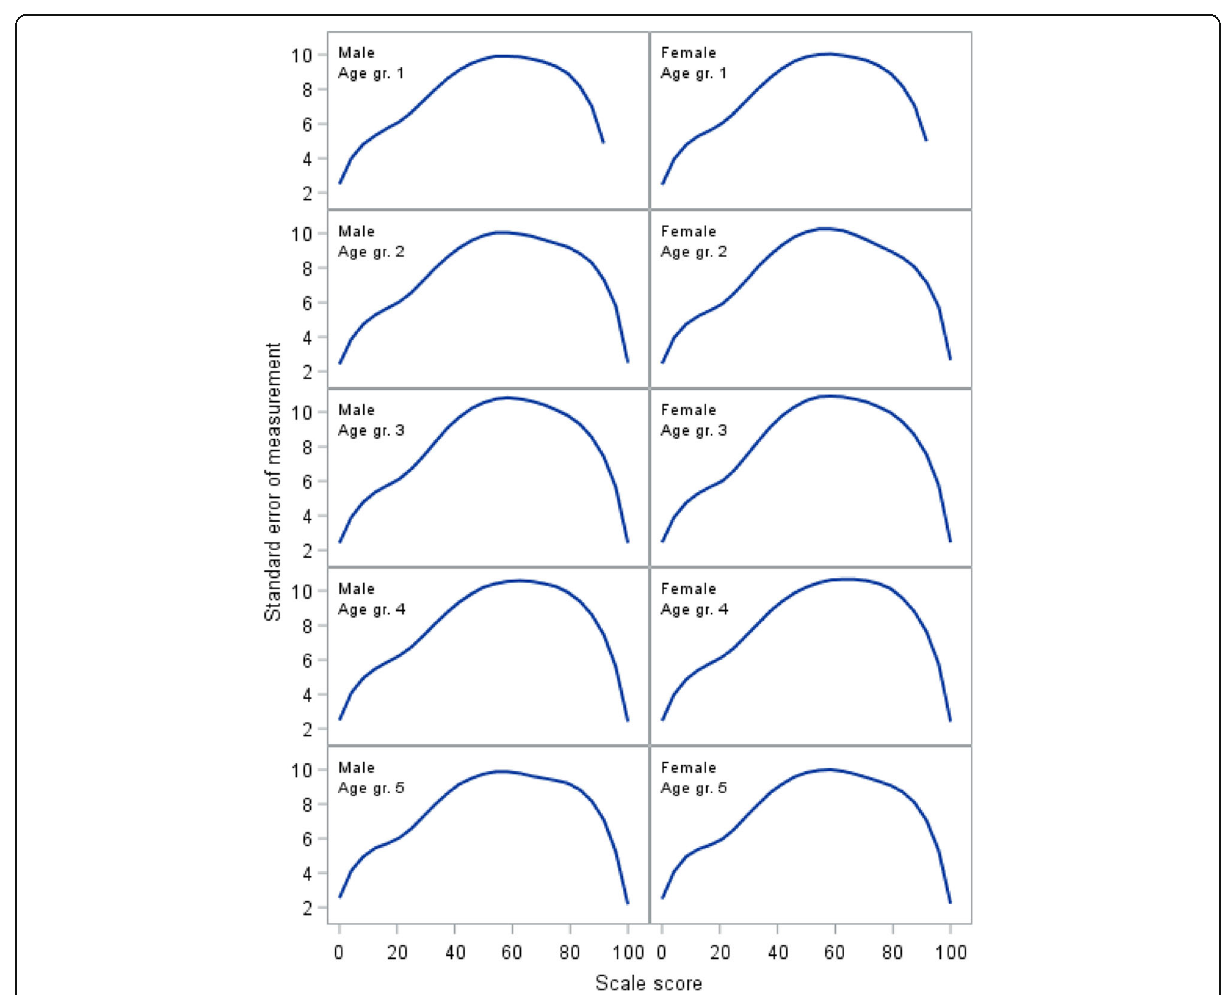
Fig. 2 Standard error of measurement for the Resources